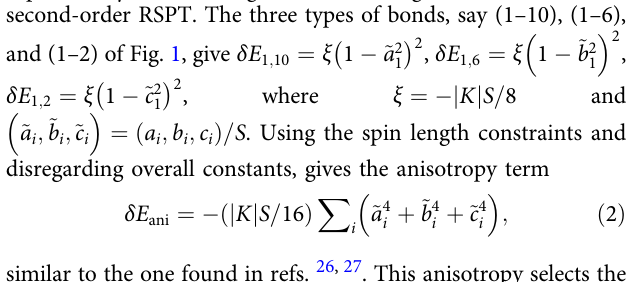
effective description in terms of dimers is to show that fl uctua- tions select the Cartesian over the non-Cartesian states. BSS made this hypothesis based on an analogy to a related 1D problem.